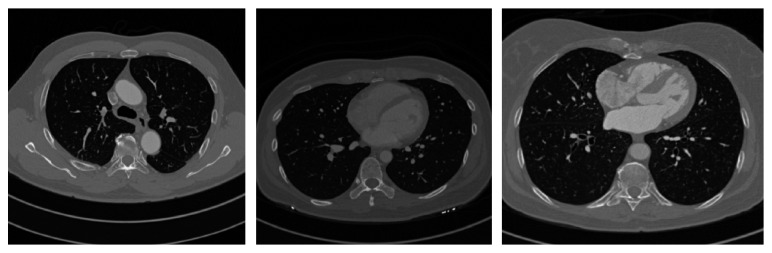
Chest CT images.